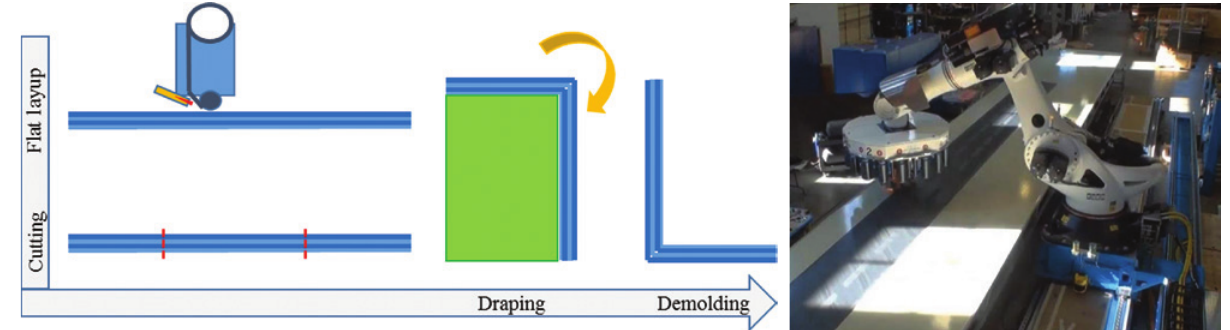
Figure 3: Schematic of flat AFP layup (left) and anthropomorphic robot mounted on an additional linear axis with an AFP head for flat preform layup (right). Source: www.electroimpact.com